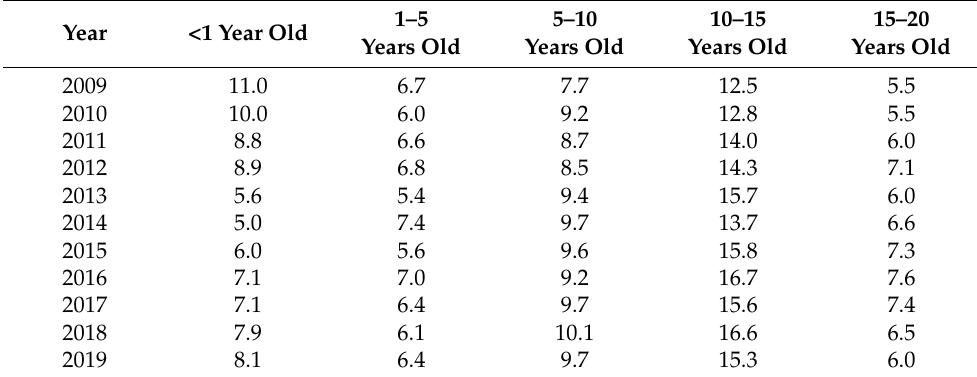
Table 2. Historic development of age-specific incidence rate, per 100,000 children.